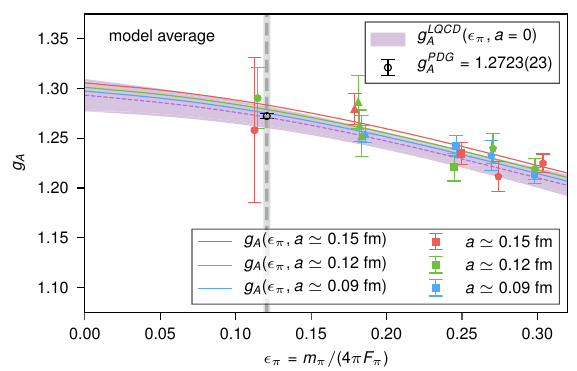
Figure 6. Extrapolation of a g A determination in Ref. [8] to the physical point. Solid red, green, and blue curves are central val- ues of g A as a function of (cid:14) π = m π / (4 π F π ) at fixed lattice spac- ing and infinite volume, and the black circle is the experimental value. Magenta band is the central 68% confidence band of the continuum and infinite volume extrapolations.